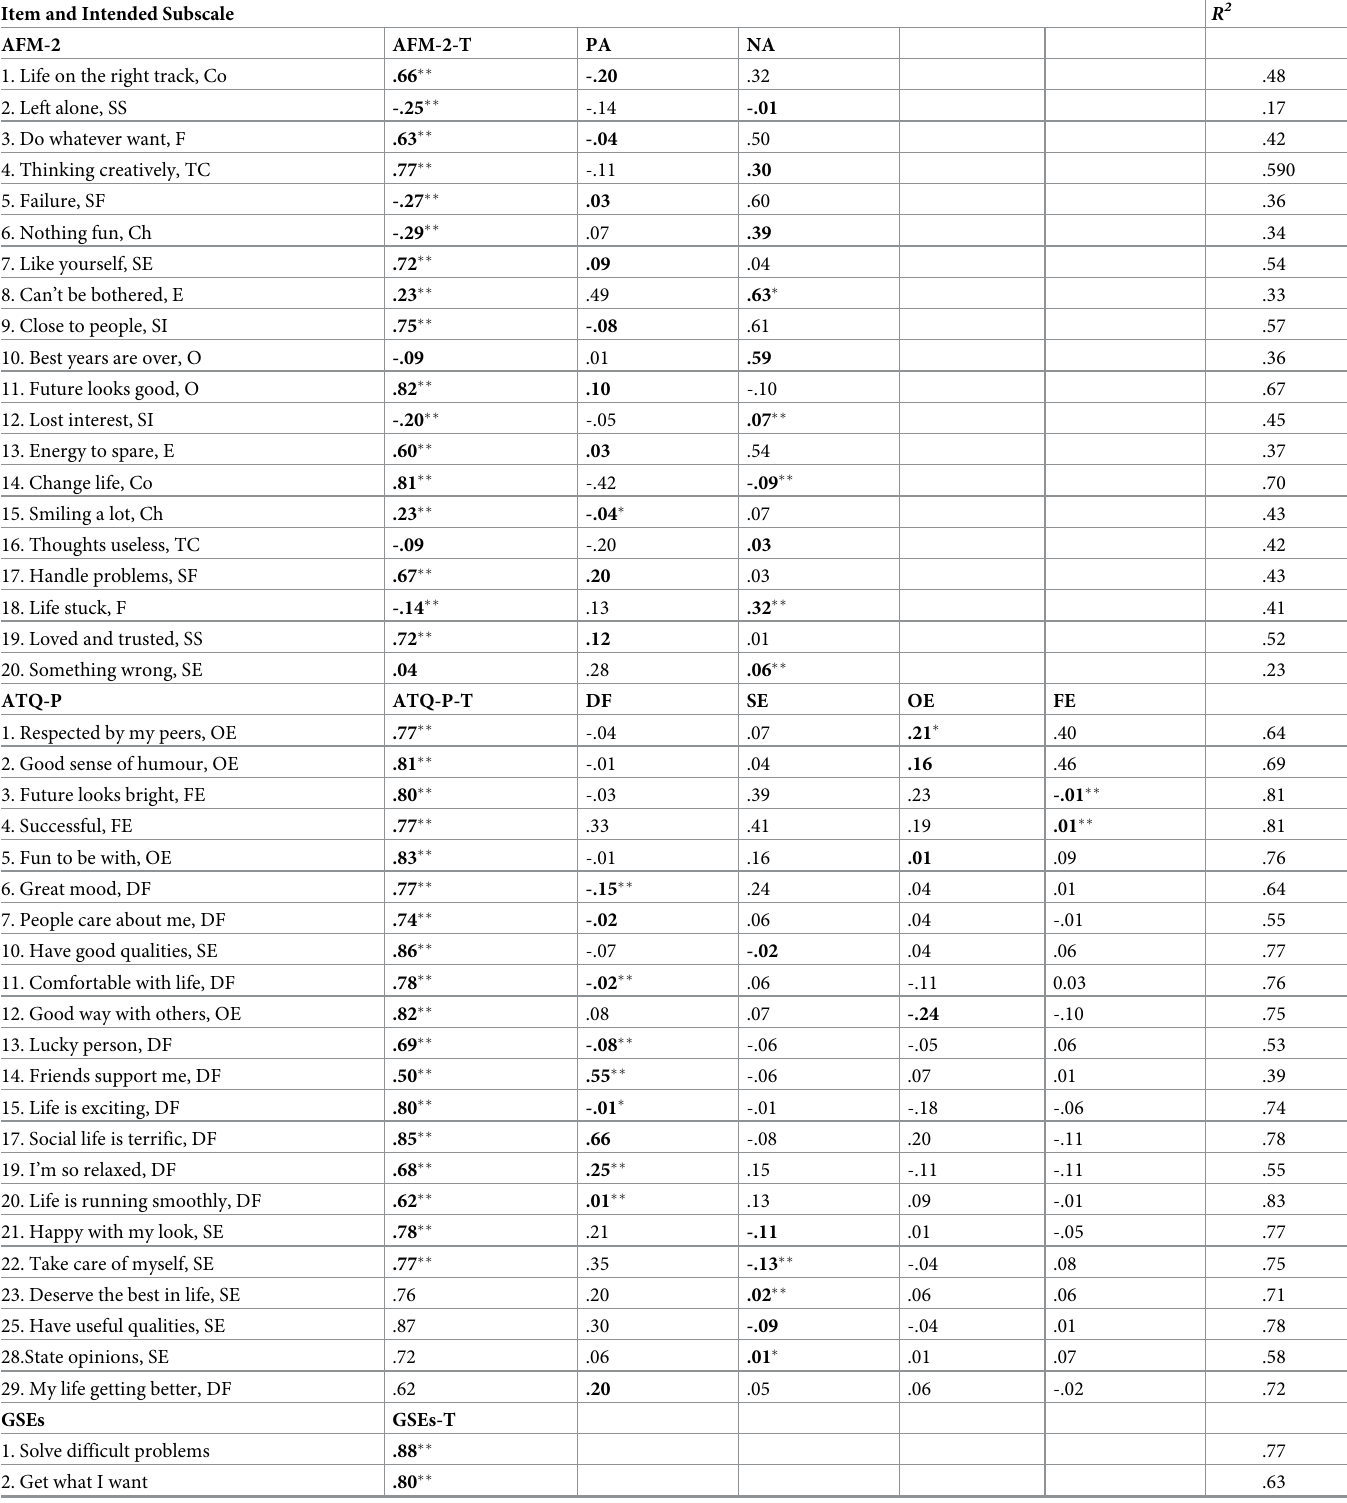
Table 3. Standardised factor loadings for models of best fit. Item and Intended